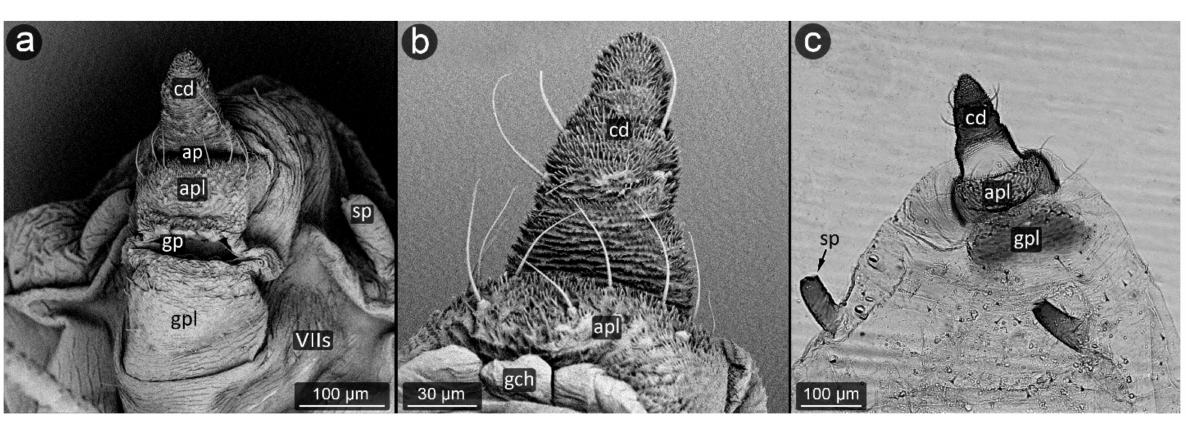
Figure 17. Perianal structure of Semiaphis dauci ; ( a )—rear view (SEM), ( b )—close-up of cauda (SEM), ( c )— rear view in light microscopy.